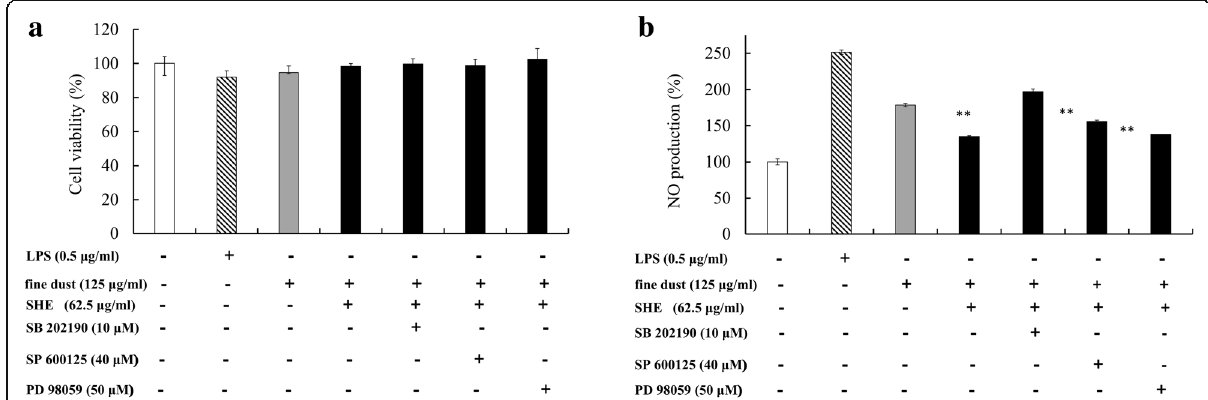
Fig. 6 The antioxidative potential of SHE against the FD-induced oxidative damage in RAW 264.7 cells. ( a ) Cell viability and ( b ) NO inhibitory effect in the presence of specific MAPK inhibitors. The cells were treated with indicated concentrations of SHE (62.5 μ g mL − 1 ) for 24 h in the presence or absence of each selective inhibitor. SB 202190= p38 inhibitor, SP 600125= JNK inhibitor, and PD98059 = ERK inhibitor. Triplicate experiments were used to evaluate the data, and the mean value is expressed as ± SD. Student ’ s t-test used to calculate the statistical significance. * = p < 0.05 and ** = p <